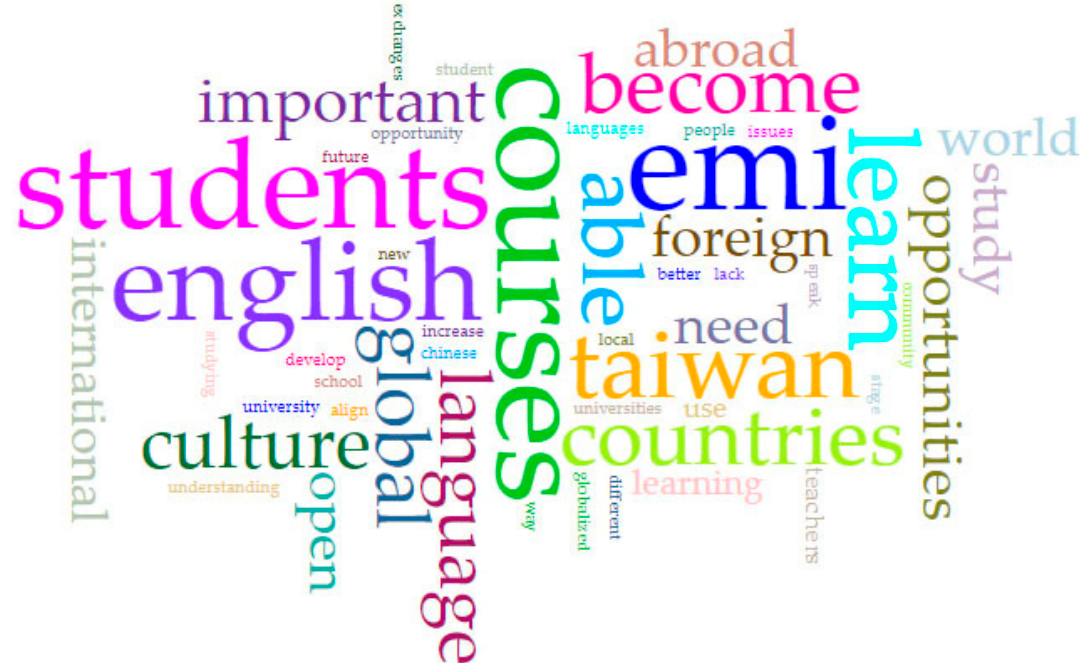
Figure 1. Keyword cloud for focus groups interview results. Table 3. Top 20 keywords.